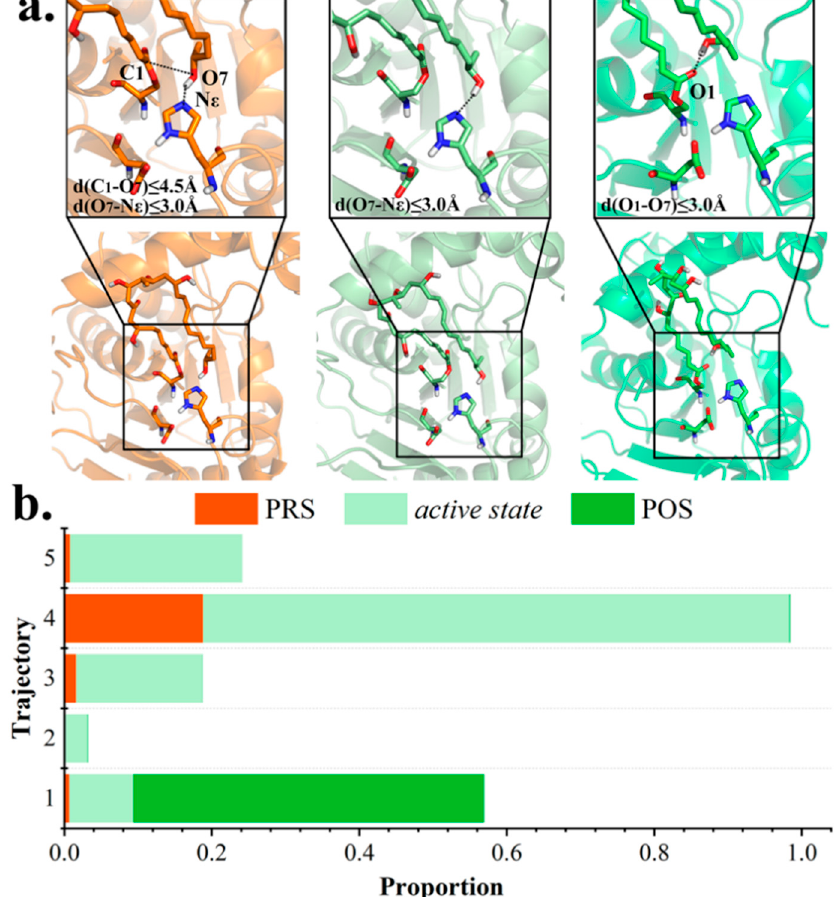
Figure 3. Classification of trajectory frames based on polyketide chain conformation. ( a ) Representative structures of PRS, active state and POS extracted from clustering analysis. ( b ) Proportion of PRS, active state , and POS in each trajectory.